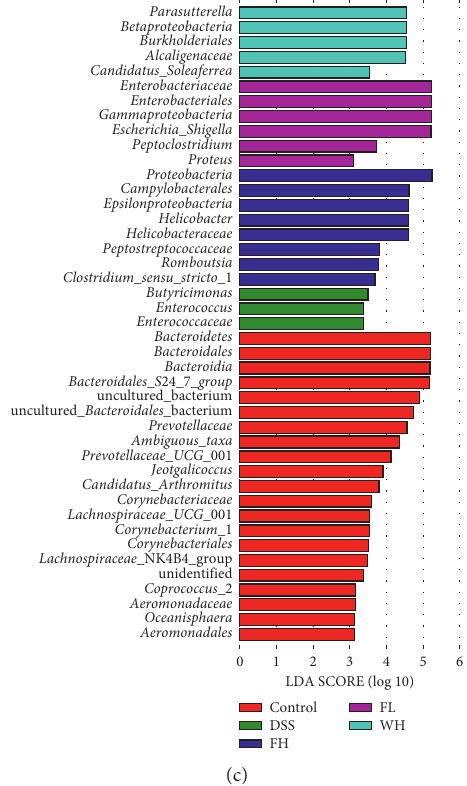
Figure 5: Structural comparison of fecal flora among different groups. (a) Bacterial taxonomic profling at the phylum level. (b) LEfSe analysis of fecal flora among different groups. (c) LEfSe analysis showing the distribution histogram of different groups in gut microbiota (LDA score >